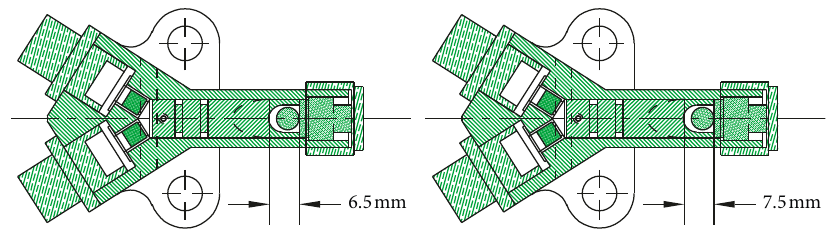
Figure 3: Diagram of the spacing between the cutter blade and the cutting